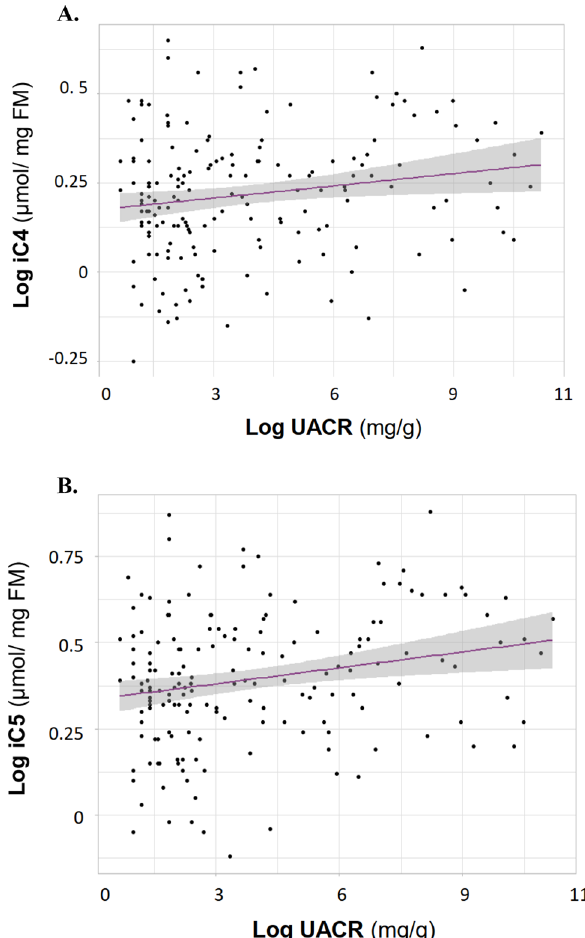
Figure 3. Branched short chain fatty acids (isobutyrate, iC4 and isovalerate, iC5) per urinary albumin to creatinine ratio (UACR). Both iC4 ( A ) and iC5 ( B ) correlated with UACR (iC4: R 2 = 0.03, p = 0.02; iC5: R 2 = 0.05, p = 0.004) in the unadjusted as well as in the adjusted model (iC4: R 2 = 0.35, p = 0.03; iC5: R 2 = 0.36, p = 0.005). The analyses were adjusted with age, sex, 24-h systolic blood pressure and estimated glomerular filtration rate. FM fecal mass. 95% CI around the regression line is shown in